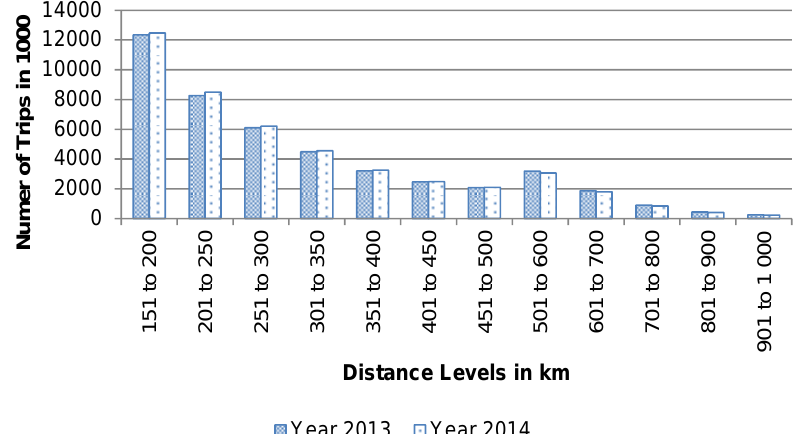
Figure 1. Number of trips for different distance levels over 150 km performed by commercial vehicles within German inland freight transportation for years 2013 and 2014 (data from [15,16]).